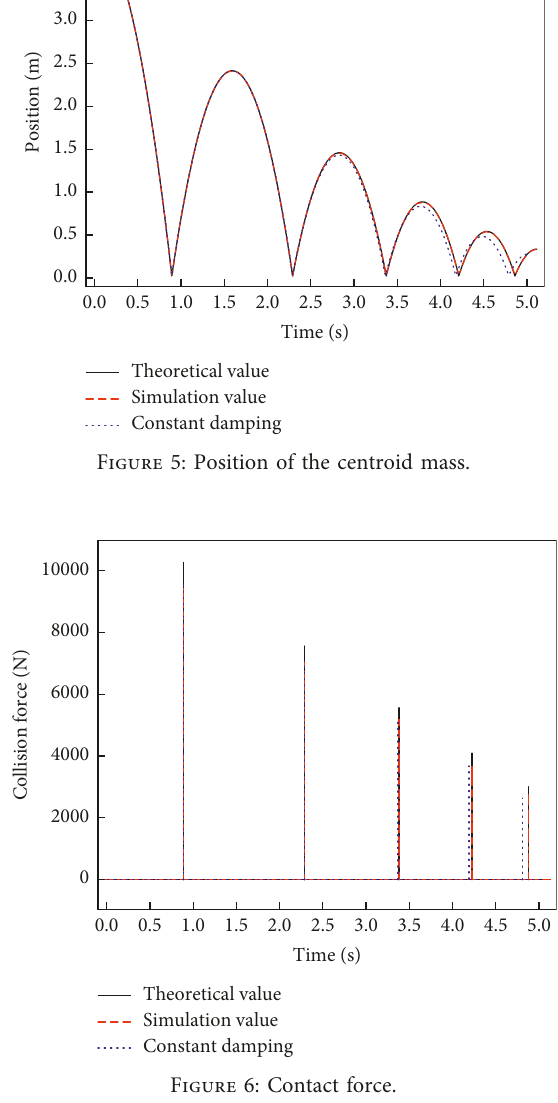
Table 1) is obtained as follows: y 0 . 15582 v 2 .